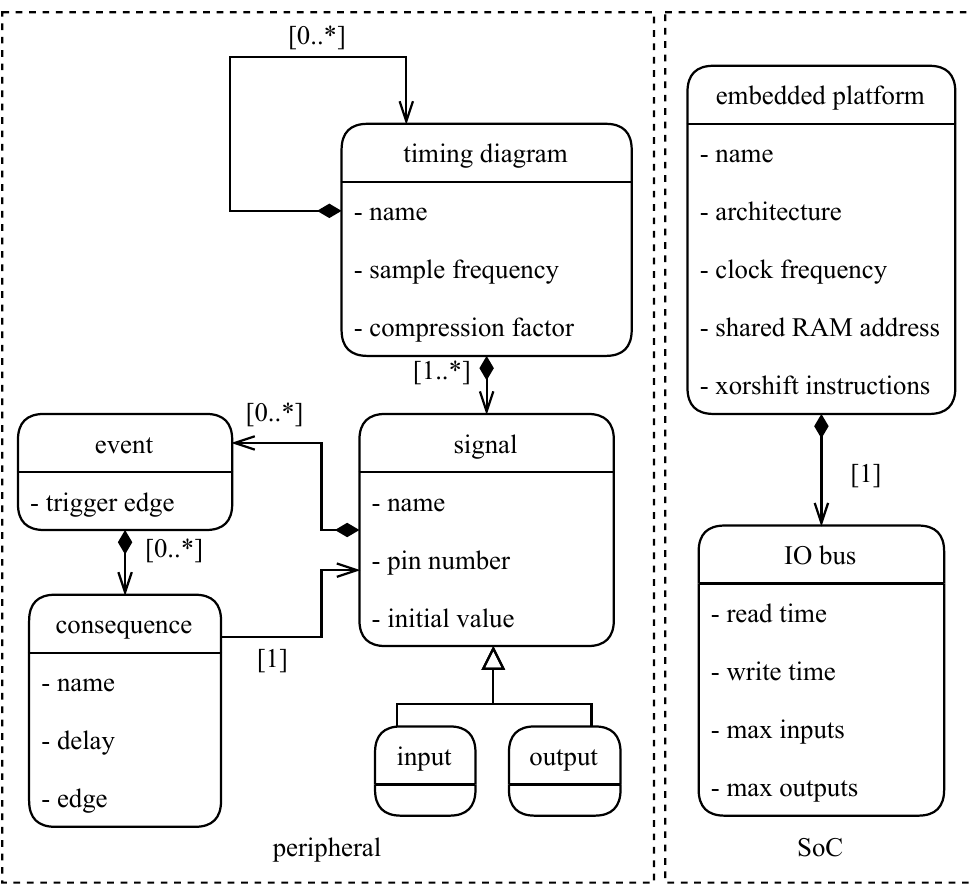
Figure 2. Simplified overview of the combined model representing the acquisition